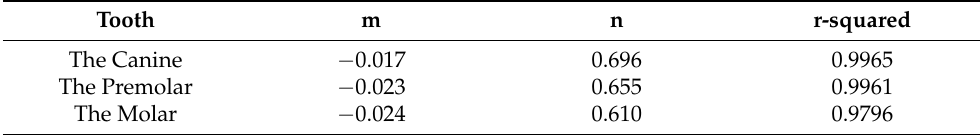
Table 2. Parameters of the linear model between the CP position and penetration depth for different teeth.